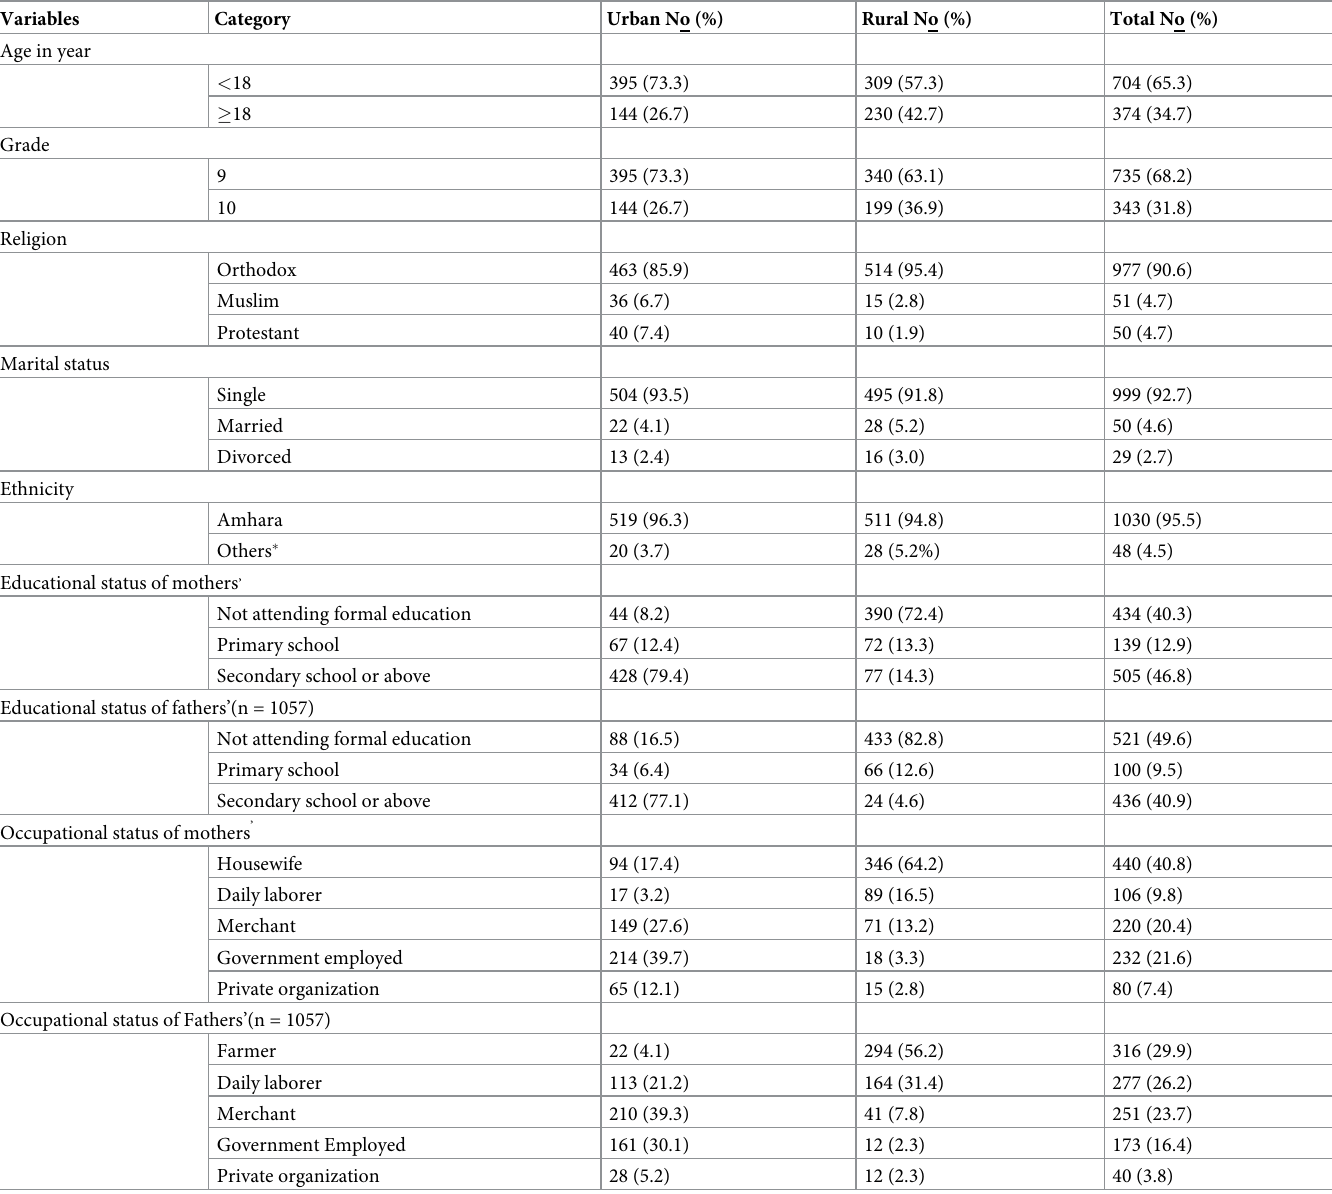
Table 1. Socio-demographic characteristics of urban and rural schoolgirls in Northeast, Ethiopia, 2020 (N = 1078: 539 urban and 539 rural).